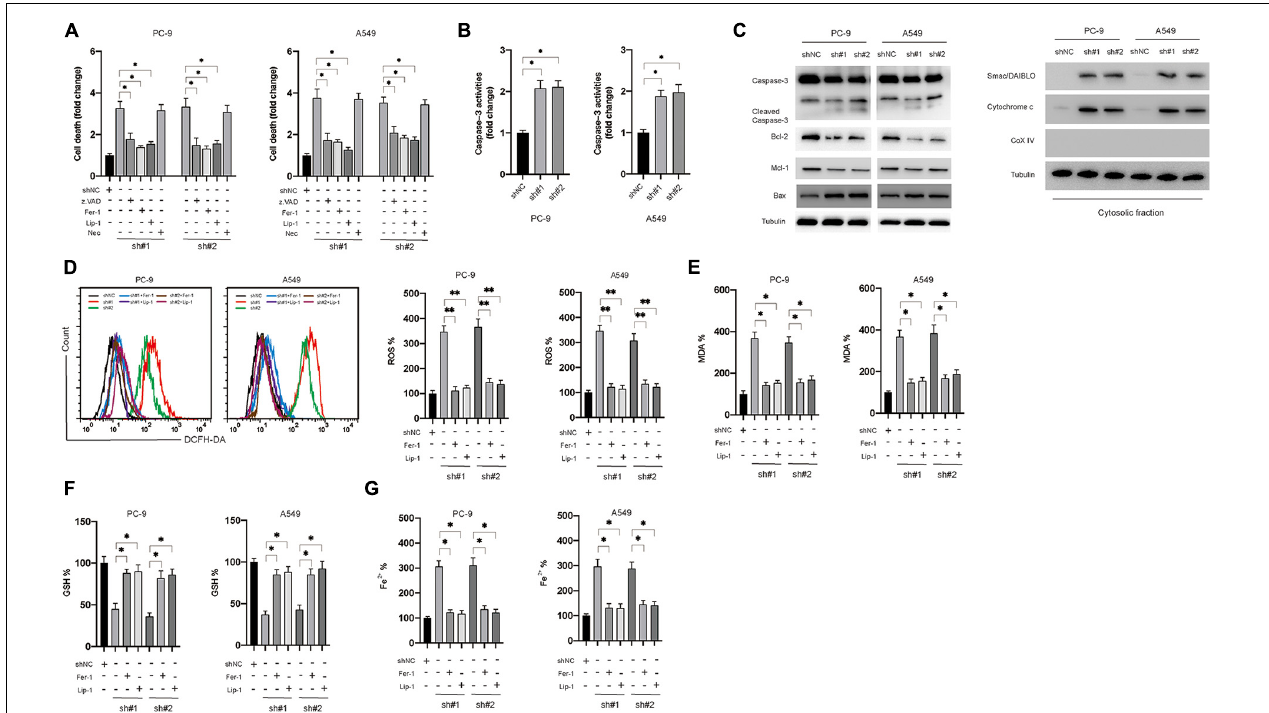
FIGURE 2 | Silencing of circDTL induced apoptosis and ferroptosis of NSCLC cells. (A) NSCLC cells were transfected as indicated with or without different inhibitors for 24 h, cellular death was assayed. (B) NSCLC cells were transfected as indicated 24 h, caspase-3 activities were measured. (C) Apoptosis-related proteins were measured by western blots. (D) NSCLC cells were transfected as indicated and treated with or without ferroptosis inhibitors (Fer-1, Lip-1) for 24 h, ROS levels were measured. (E) MDA levels. (F) GSH levels. (G) Fe 2 + levels. Data were presented as mean ± SD. Experiments were performed at least three times. ∗ P < 0.05; ∗∗ P <